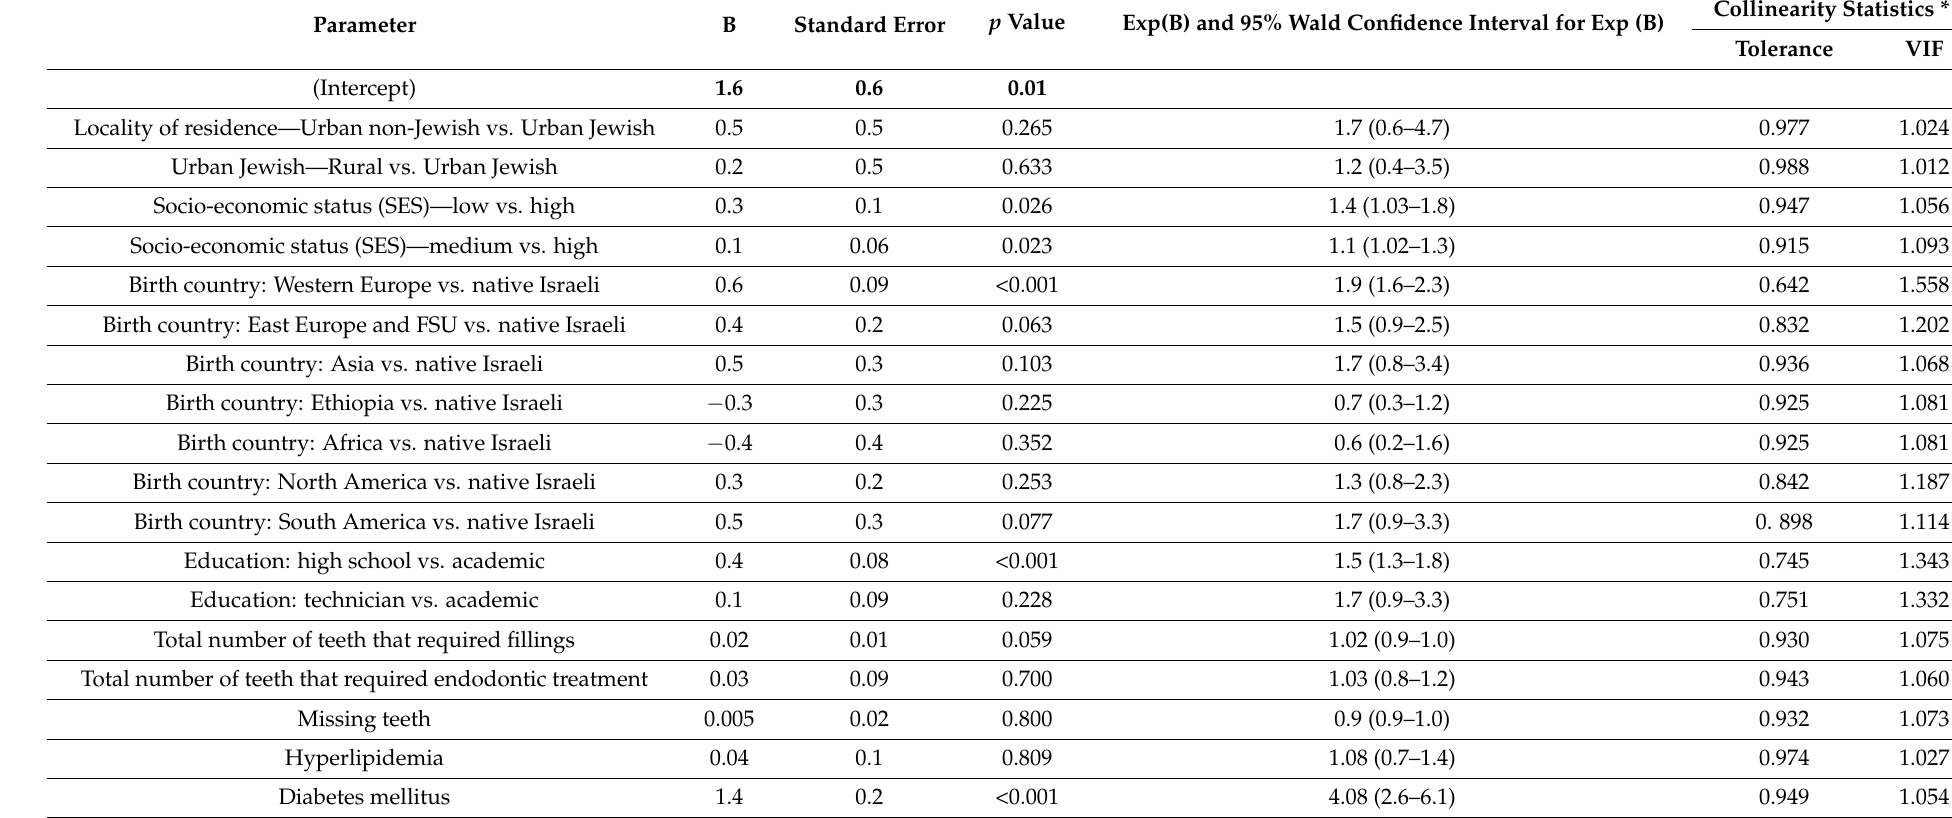
Table 6. Multivariate logistic regression analysis for hypertension diagnosis as the dependent variable with statistically significant independent parameters among the sub-population of age-, sex- and smoking-matched